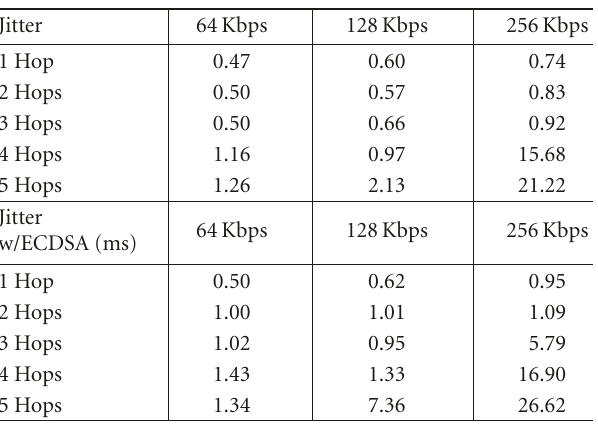
Table 10: Jitter both with and without data authentication Unicast routing, autoconfiguration, Real-Time, and PACP are active.